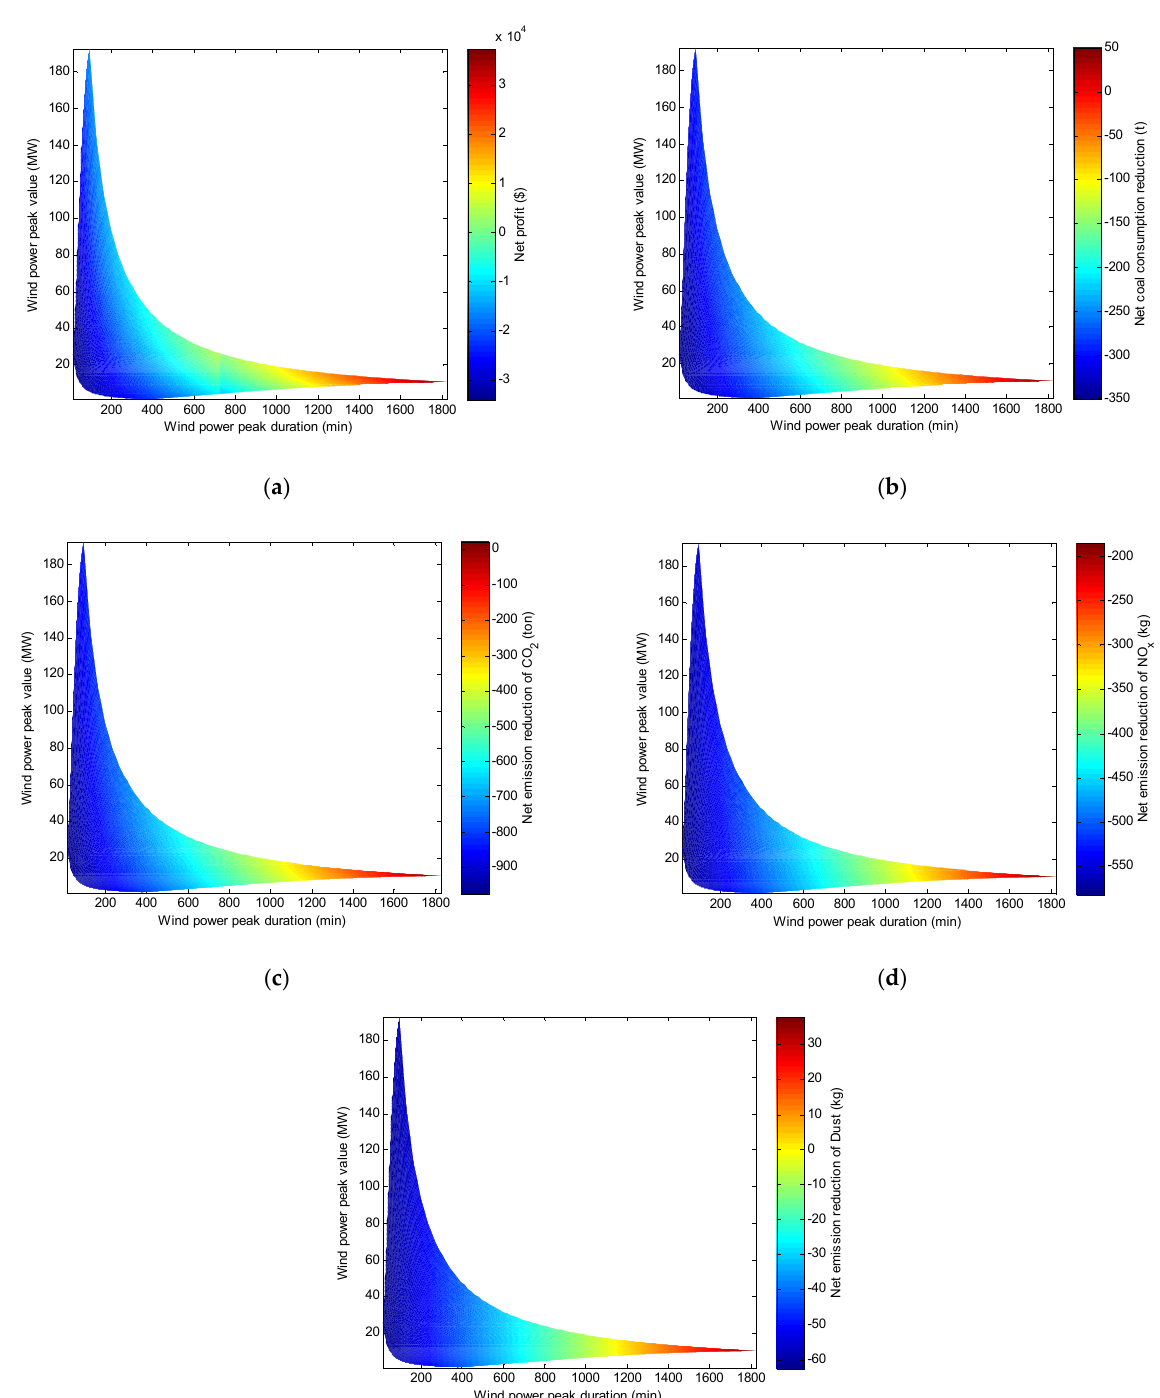
Figure 7. Net profit and net emission reduction of the wind–coal combined power generation system of strategy (3) against wind energy curtailment strategy for wind power peaks above 540 MW. ( a ) Net profit; ( b ) Net coal consumption reduction; ( c ) Net emission reduction of CO 2 ; ( d ) Net emission reduction of NO x ; ( e ) Net emission reduction of